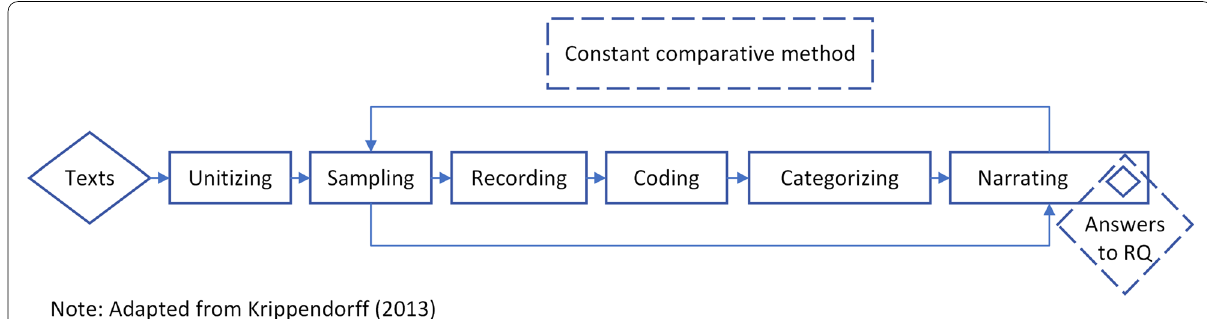
Fig. 1 Components of the research